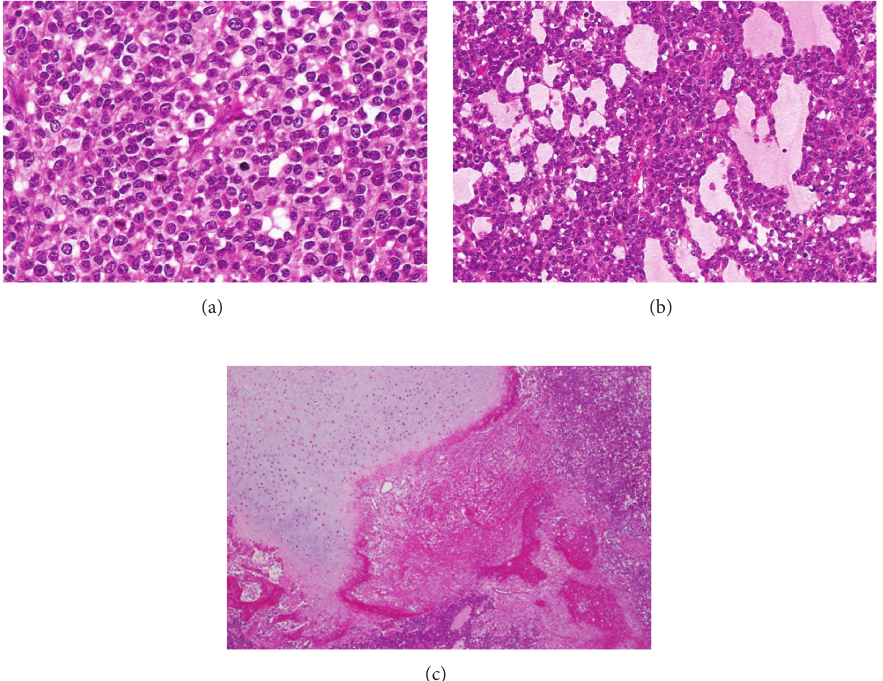
Figure 3: Histological examination of the resected buttock tumor, showing a poorly differentiated round cell malignant neoplasm, growing in sheets. The tumor cells had scant, pale eosinophilic cytoplasm. Hematoxylin and eosin staining, original magnification × 400 (a) and × 200 (b). There were large areas of well-differentiated cartilage, showing focal endochondral ossification ((c), ×